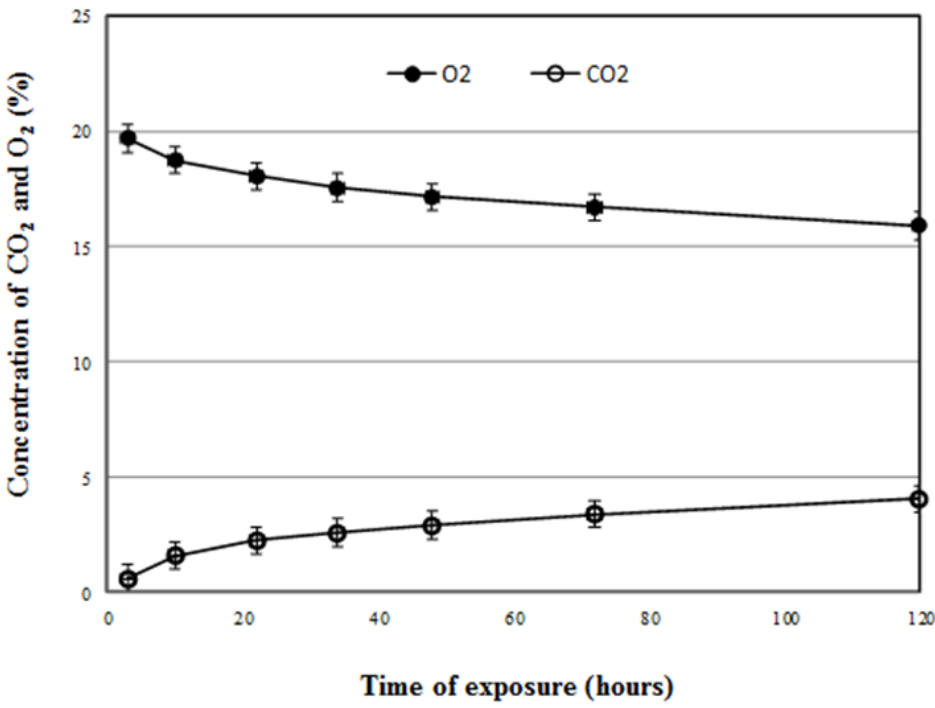
Figure 5. Concentrations of carbon dioxide and oxygen during five days of exposure at 25 °C (error bars indicate the standard deviation, n = 10).